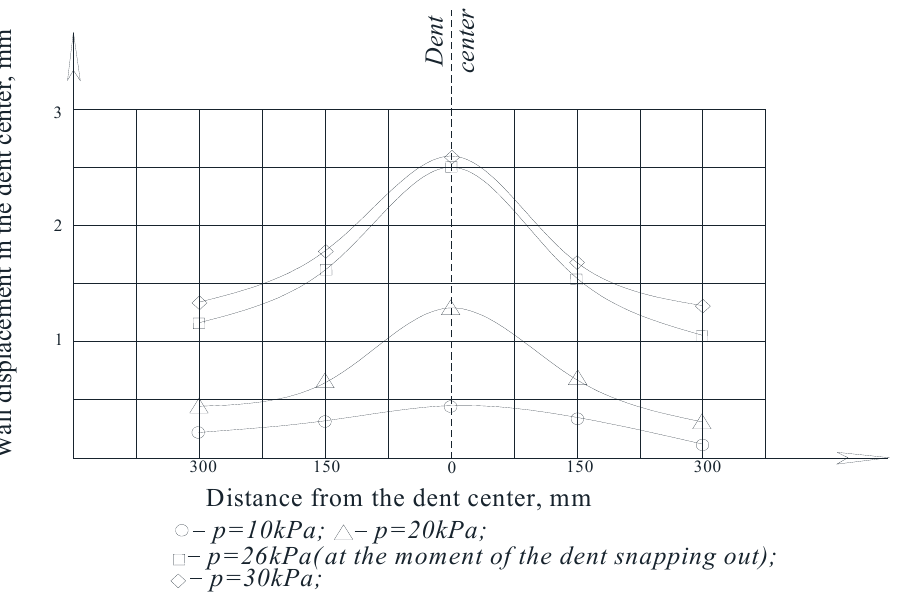
Figure 11. The wall displacements of the model, M2 ‐ A, at the characteristic elliptical dent zone points in the direction of the large ellipse radius.